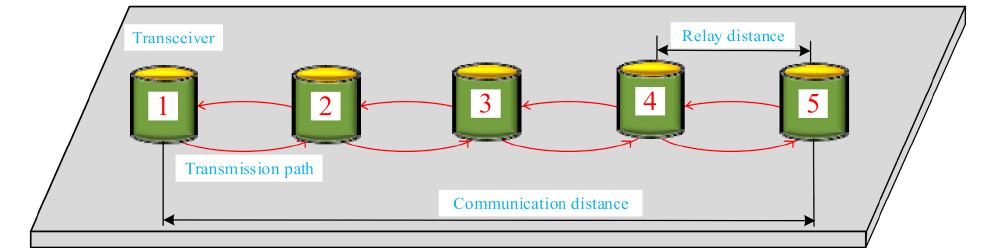
Figure 1. A long-distance transmission scheme about seismic